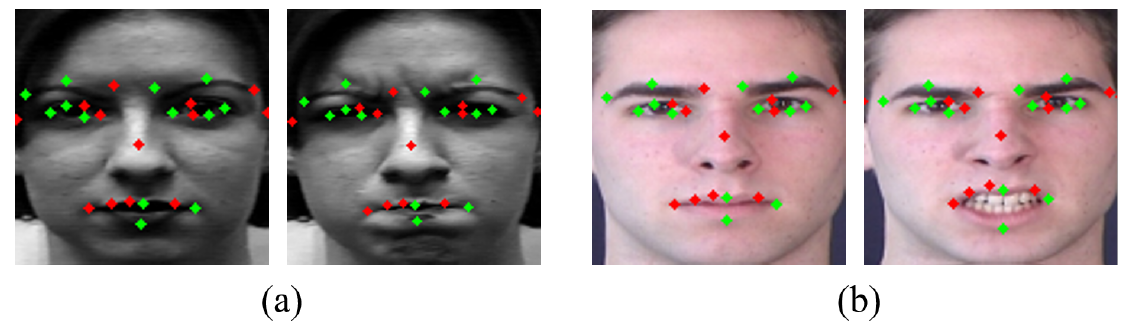
Figure 9. Twenty-three landmarks used as the input of geometric network: ( a ) CK+ dataset; and ( b ) MMI dataset.